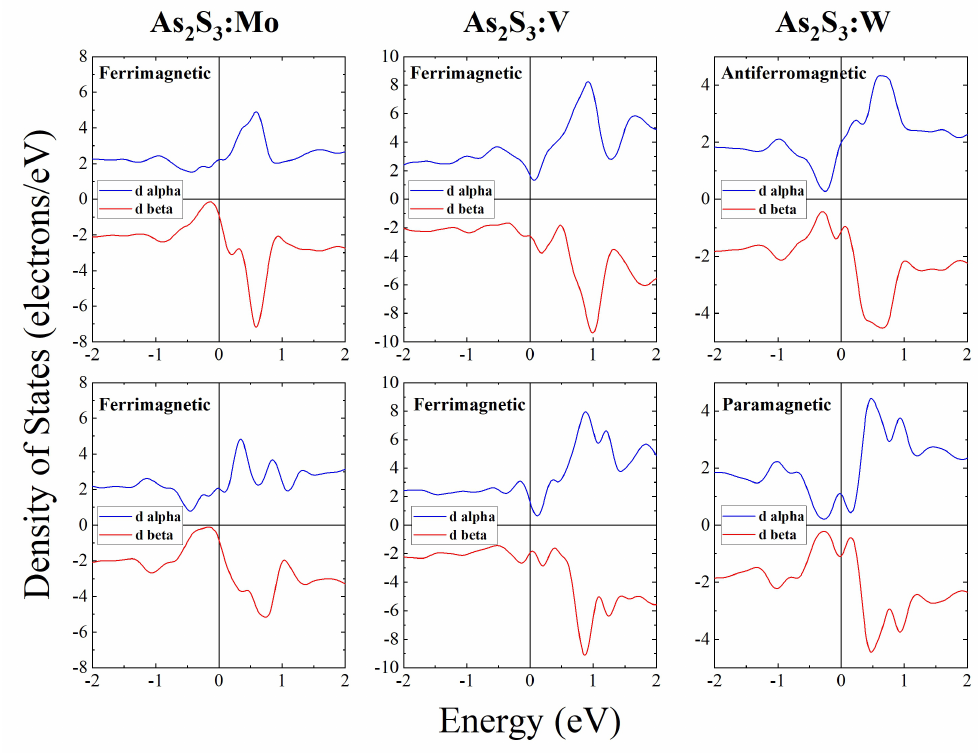
Figure 5. Partial densities of Mo d -states, V d -states and W d -states for mq structures ( upper panel ) and for mq-GOpt structures ( lower panel